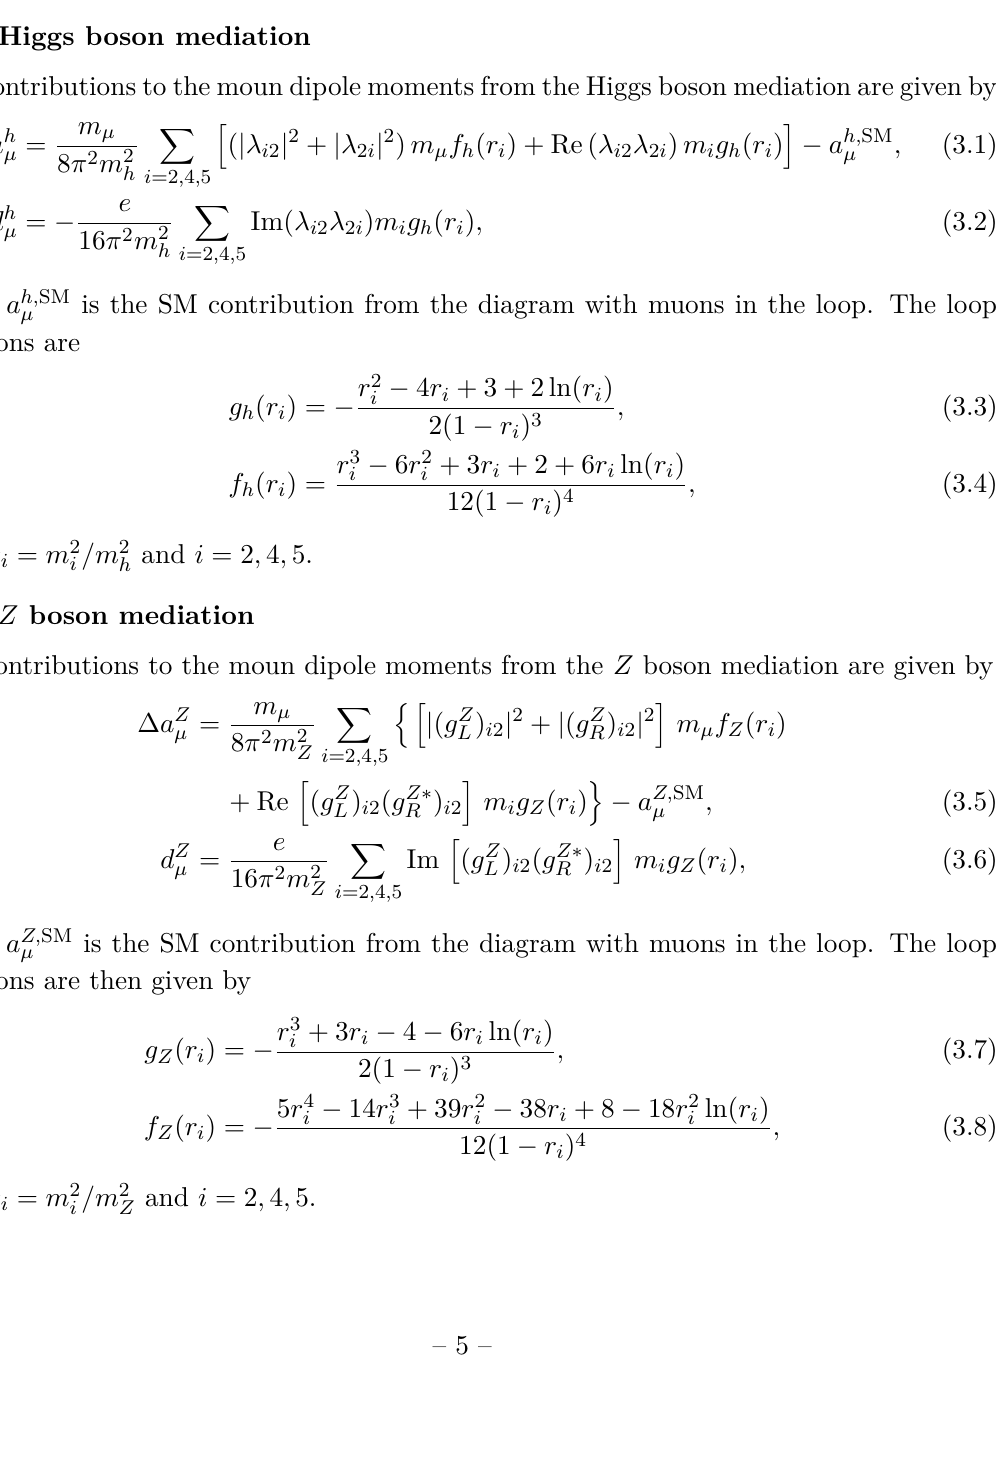
Figure 1 . One-loop contributions to the muon dipole moments. ‘ 2 , 4 , 5 are the muon and two vector-like leptons in the mass basis, while ν 2 , 4 are the muon neutrino and the heavy neutrino in the vector-like doublet,